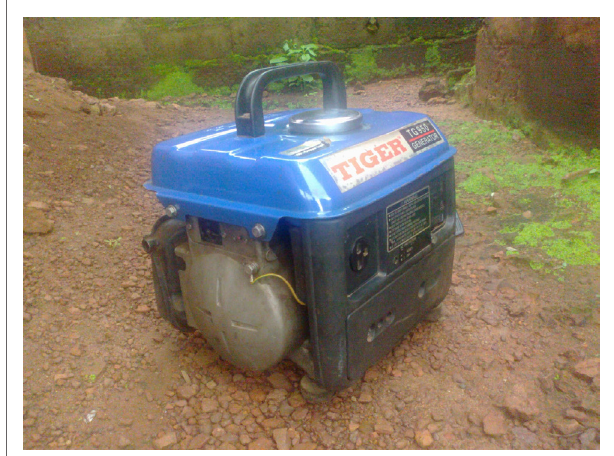
FigUre 1 | Picture of Tiger generator – Tg 950 650Va model